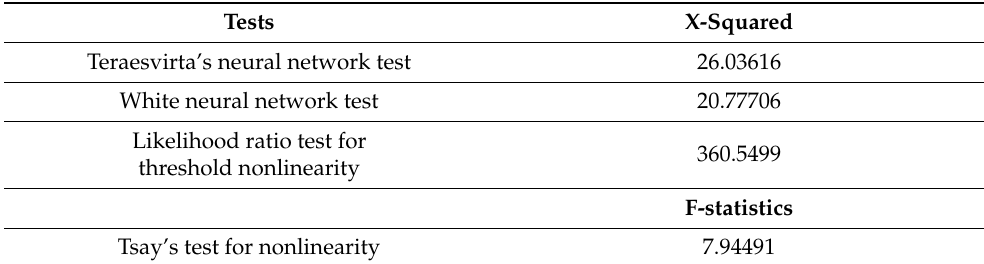
Table 2. Nonlinearity Test Statistics.